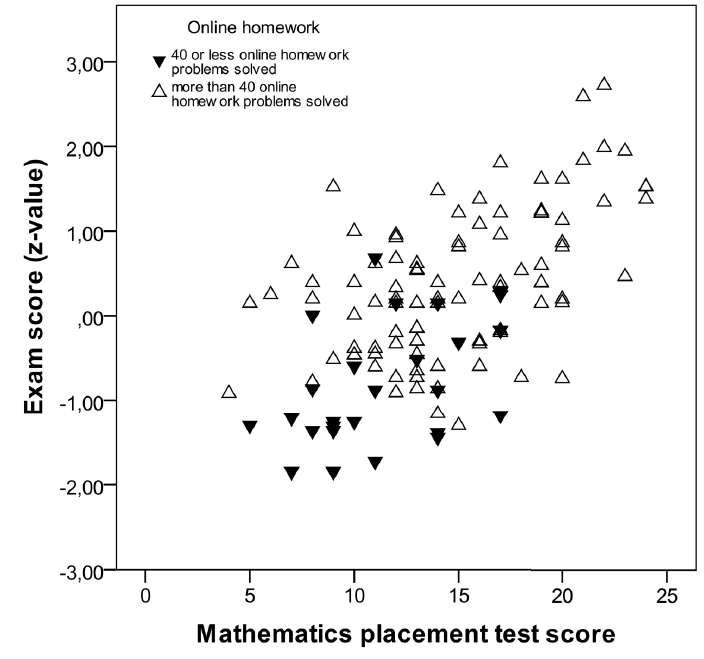
Fig. 5. The exam scores compared to the mathematics placement test